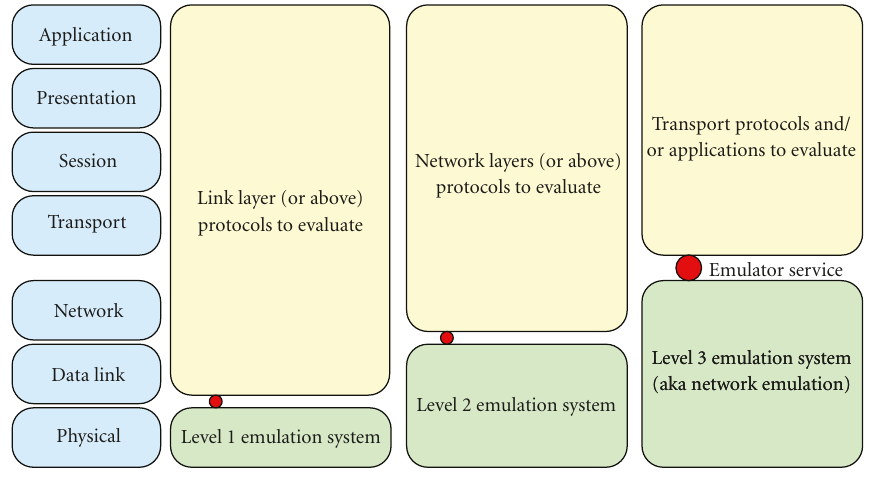
Figure 1: Levels of